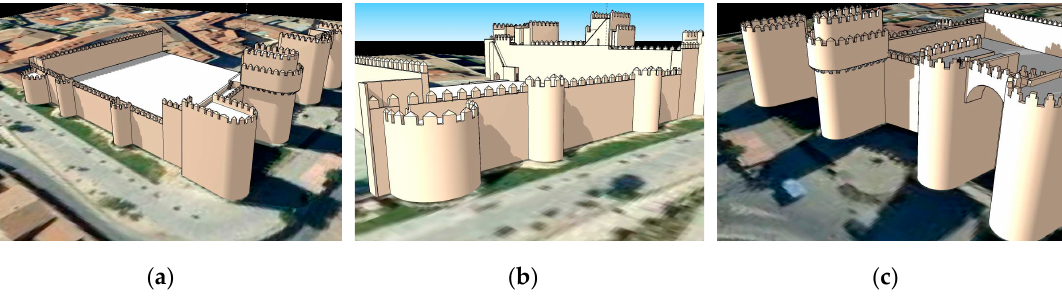
Figure 7. Different view of the reverse modeling process corresponding to the current state: ( a ) southeast view; ( b ) southwest view; ( c ) northeast view. [1].